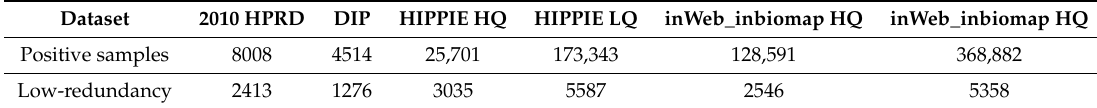
Table 2. Validation datasets.